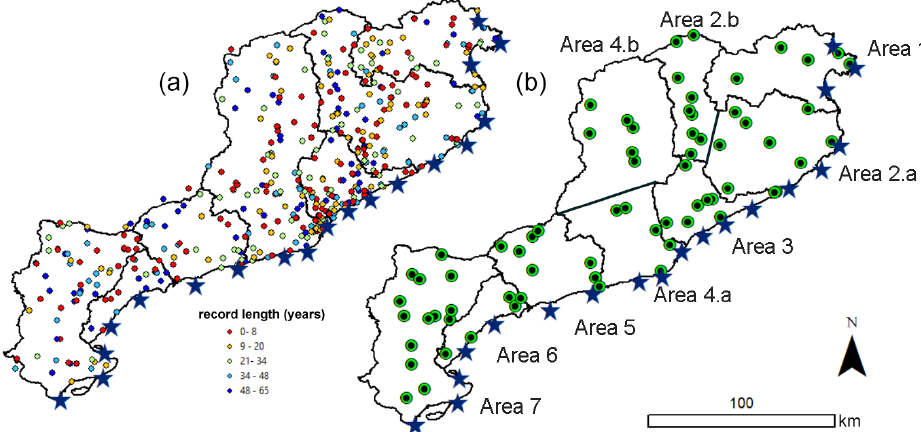
Figure 2. Location of existing rain gauges, AWSs (coloured dots), and wave nodes (stars) in the different drainage basins along the Catalan coast (a) . Selected AWSs per drainage basin (areas) along the coast (b) .